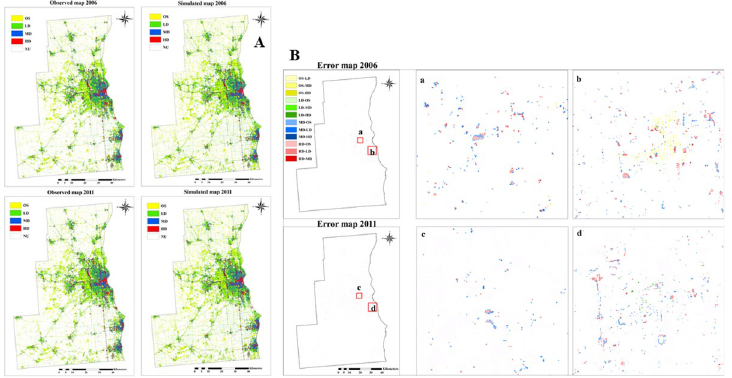
Fig 7. Observed, simulated maps and error maps for 2006 and 2011. (A) Observed, simulated maps for 2006 and 2011.(B) error maps for 2006 and 2011.Labels of XX-YY means XX was observed, but predicted to be